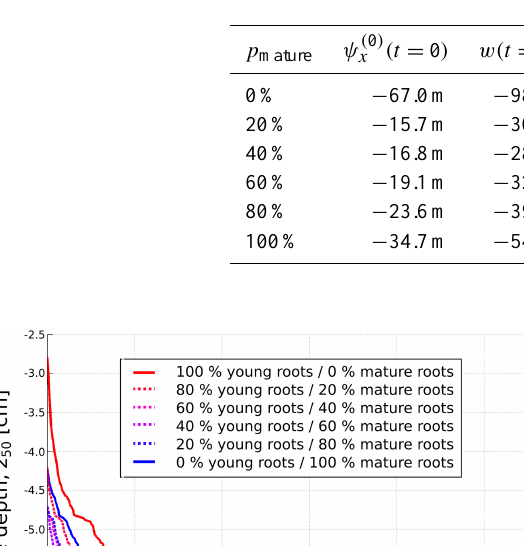
Table 3. Initial collar potential ψ 0 x (t = 0 ) , effort after 5 days of simulation time w(t = 5d) , effort at the onset of water stress ˜ w , water yield at the onset of water stress ˜ v and mean uptake depth z 50 for the fixed root geometry with a total length of l total = 9 . 93m, depending on hydraulic parameterization. Data were obtained with the “aRoot” model for roots containing between 0 and 100% of mature roots.